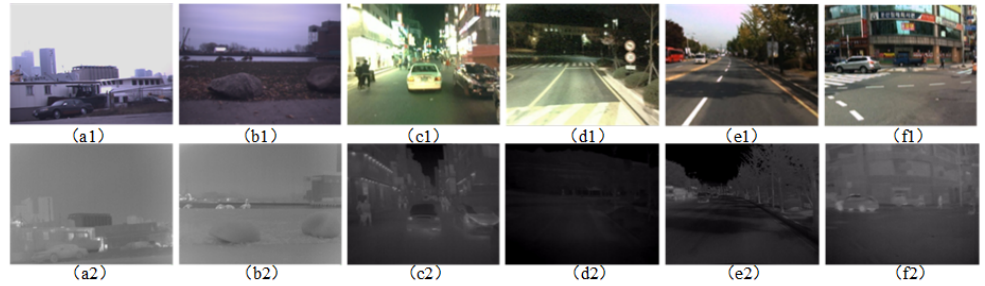
Figure 13. Test images in Table 4 (( a , b ) are from OutdoorUrban dataset; ( c , d ) are from night videos of KAIST dataset; ( e , f ) are from daylight videos of KAIST